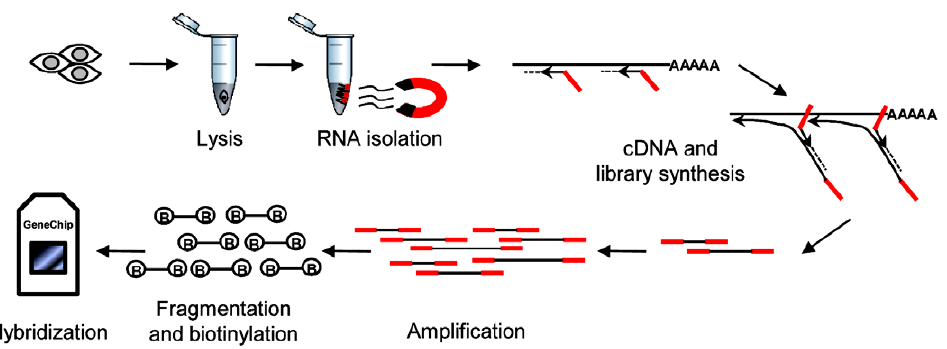
Figure 1. Workflow of Pico Profiling. Cells are lysed, RNA is purified by magnetic beads, cDNA is synthesized followed by library preparation and amplification; after column purification, cDNA is fragmented and biotinylated, followed by hybridization to a microarray.